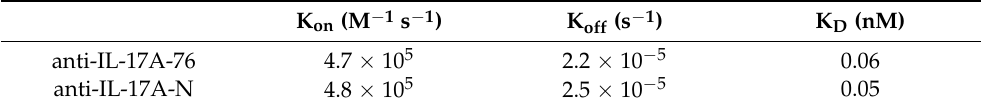
Table 4. Kinetic constants of the interactions of IL-17A with anti-IL-17A mutant forms.